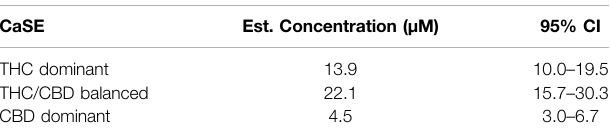
FIGURE 4 | CaSE promotes Rho activation in CB1 expressing cells in comparison to Δ 9 -THC. HEK293 cells expressing CB1 along with Rho sensor were stimulated with indicated concentrations of Δ 9 -THC in buffer or 8-fold diluted indicated extracts prepared in media with 30% MeOH: Media with only 30% MeOH, CaSE and CSE. There was an increase in CB1 activation in cells exposed to CaSE from THC dominant, THC/CBD balanced and CBD-dominant cannabis, but not Media with MeOH or CSE. Buffer was 8-fold dilution of 30% MeOH/DMEM with Tyrode ’ s buffer. Data were expressed as a ligand-promoted BRET ( Δ BRET) by subtracting BRET ratio in control media. Data represent mean ± SEM of three to fi ve independent experiments. TABLE5| EstimationofTHCconcentrationin100%CaSE.THCconcentrationsin CaSE were estimated from interpolation of standard THC concentration response curve in Figure 4